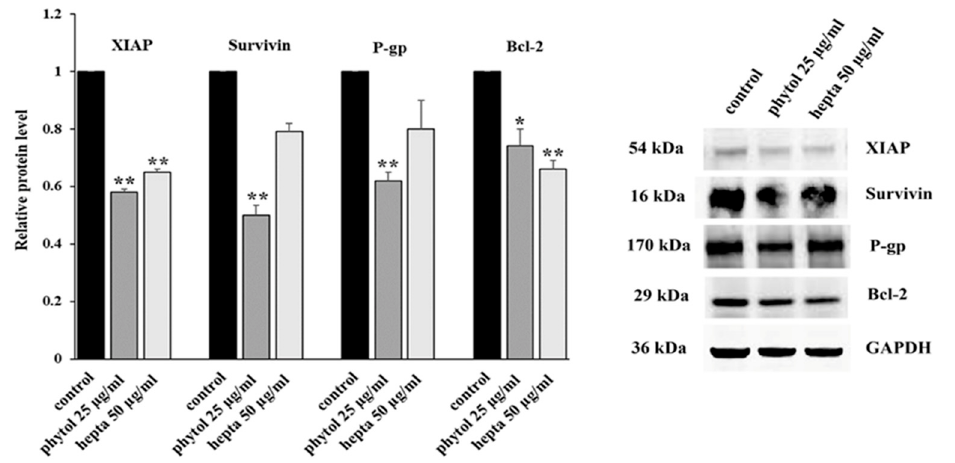
Figure 2. Genes mRNA expression levels by quantitative polymerase chain reaction in HL-60R cells. The cells were treated for 24 h with phytol (25 µg/mL) or heptacosane (hepta; 50 µg/mL). Data are expressed as mean ± standard error of three experiments. Differences when treatments are compared to the control, ** p < 0.01, * p < 0.05 (one-way ANOVA followed by Tukey’s test).